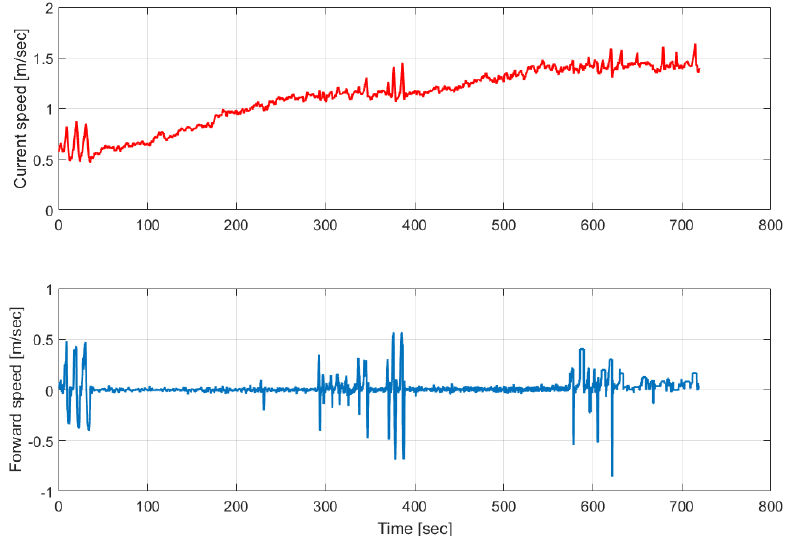
Figure 13. Vehicle’s forward motion test results in the circulating water